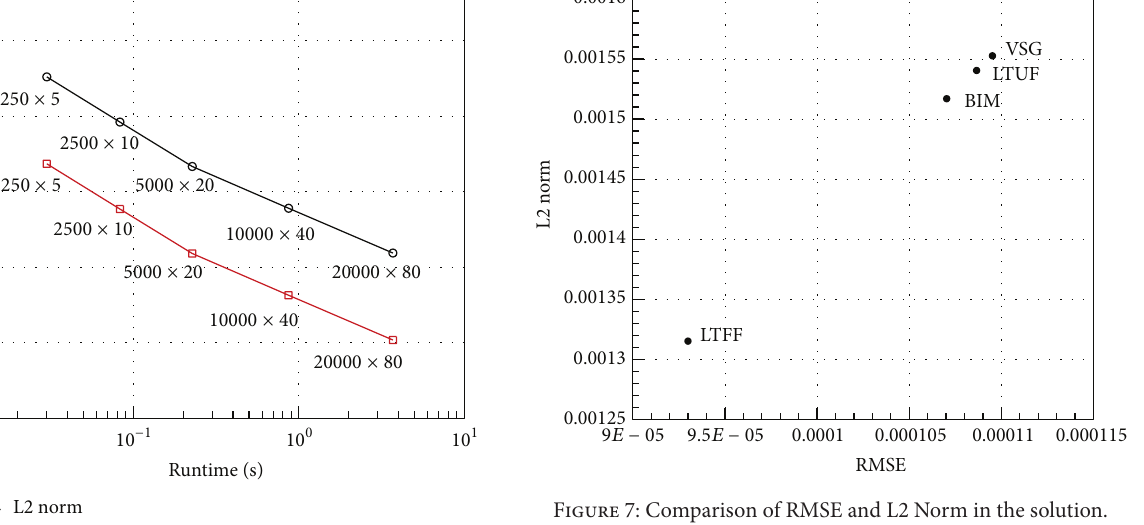
Figure 7: Comparison of RMSE and L2 Norm in the